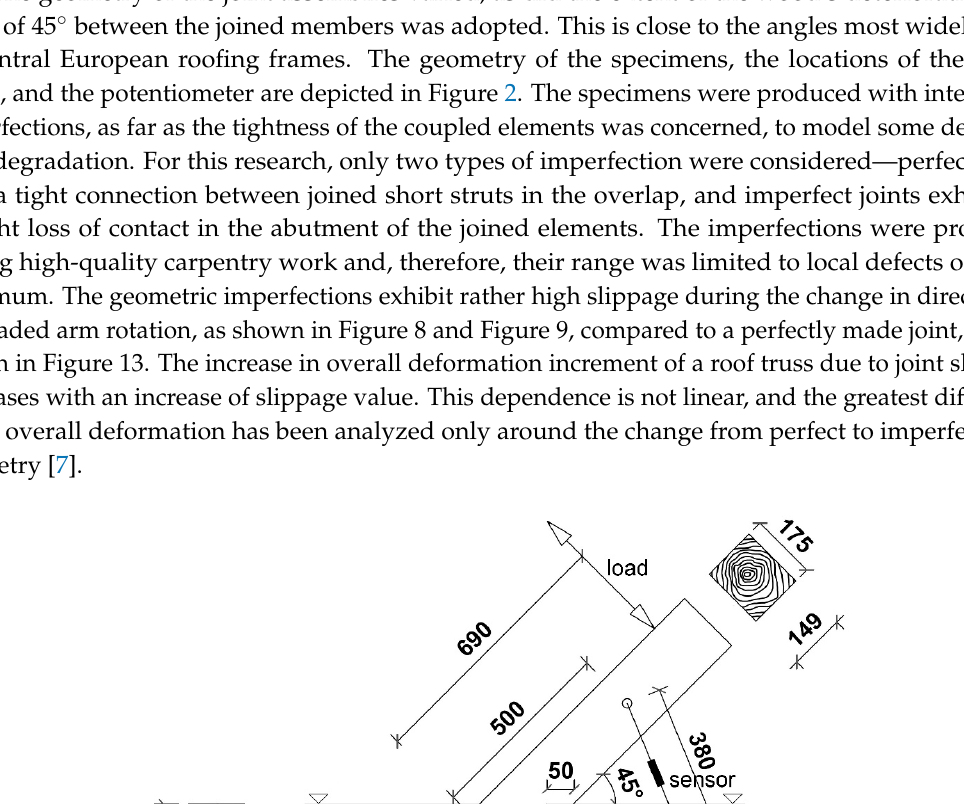
Table 1. Material characteristics.